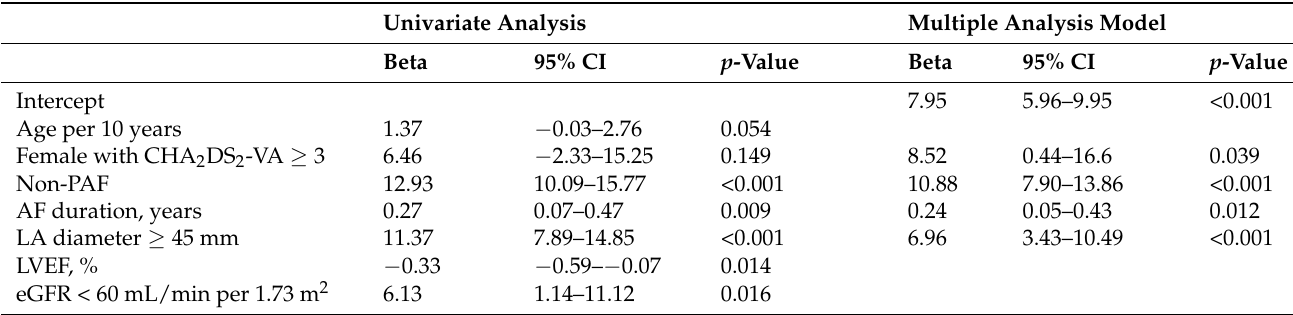
Adjusted R 2 for the selected multiple lineal regression model = 0.166, CI, confidence interval; PAF, paroxysmal AF; LA, left atrial; LVEF, left ventricular ejection fraction; eGFR, estimated glomerular filtration